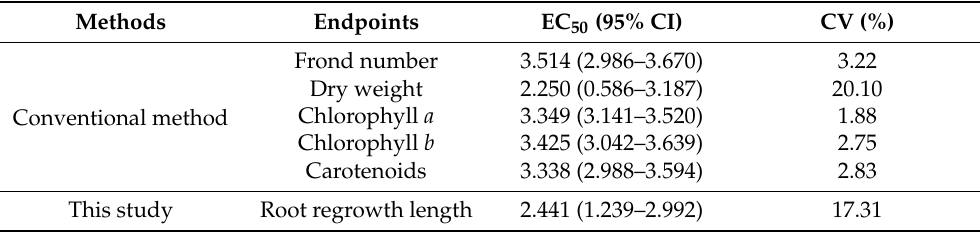
Table 2. EC 50 (mg L − 1 ) values (95% CI) and Coefficient of variation (CV, %) of Lemna minor derived from the root-regrowth method and ISO 20079 after exposure to 3,5-dichlorophenol.